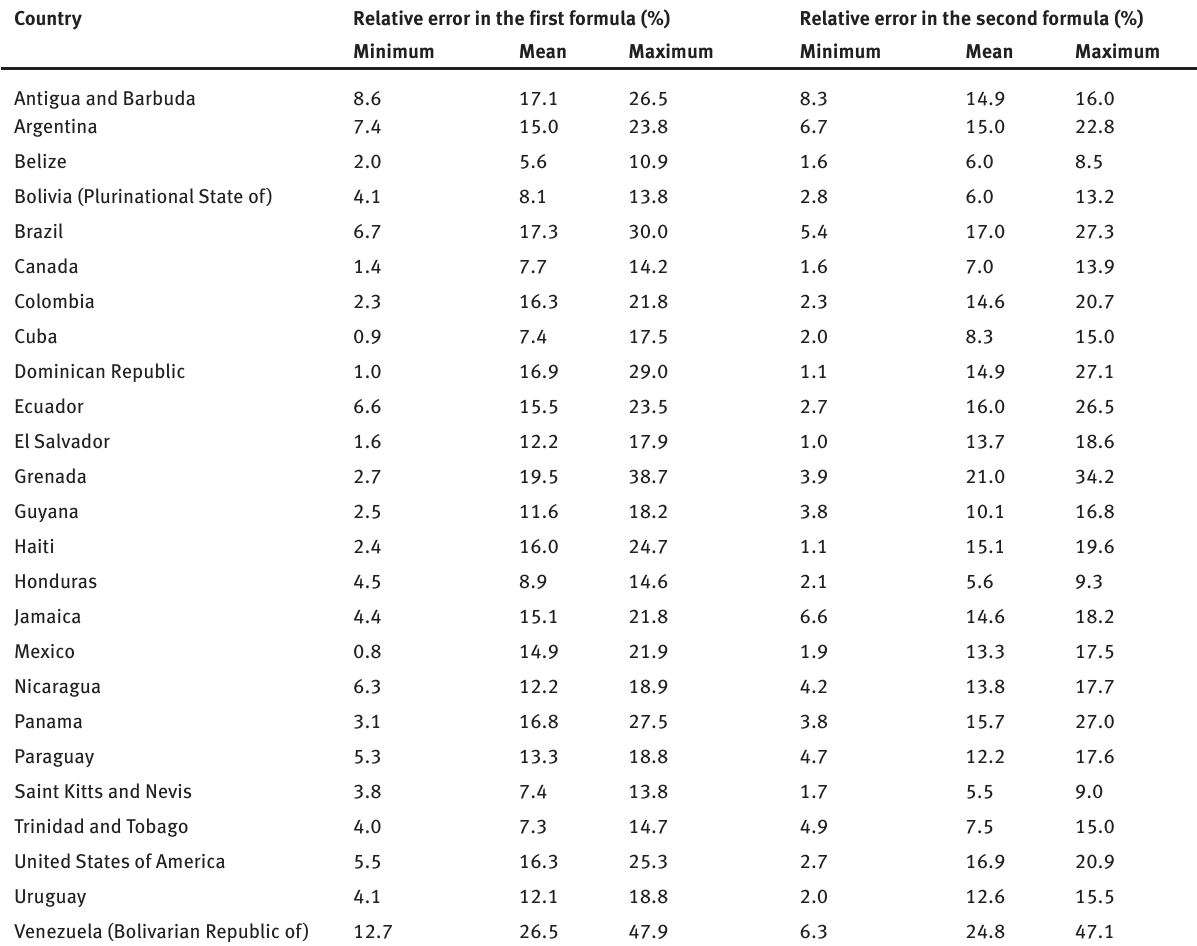
Table 3: Calculated errors for suggested functions (Tables 1 and 2), the errors less than 10% show a suitable status, the errors between 10% and 20% show a fairly status, and the errors more than 20% show a difficult status to apply the Eqs. 8 and 9 (the first and the second formulas, respectively) Country Relative error in the first formula